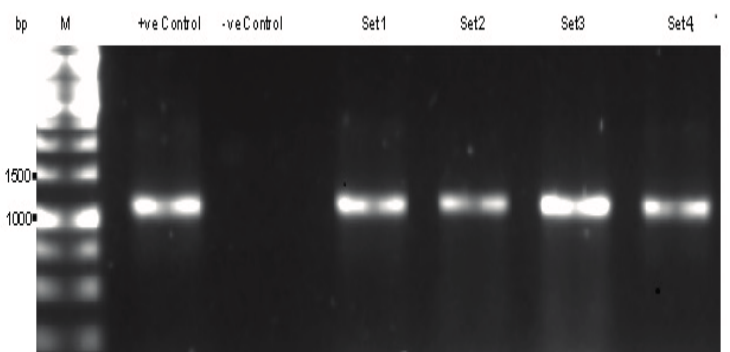
Figure 1. Agarose gel electrophoresis of Polymerase Chain Reaction (PCR) products of Pectobacterium chrysanthermi using the macergens specific primers (M101F + M1208R, M182F + M1190R, M180F + M1190R, M57F + M296R) designed in this study, which give the expected size of approximately 1100 base pairs; M: 1 kb Molecular weight